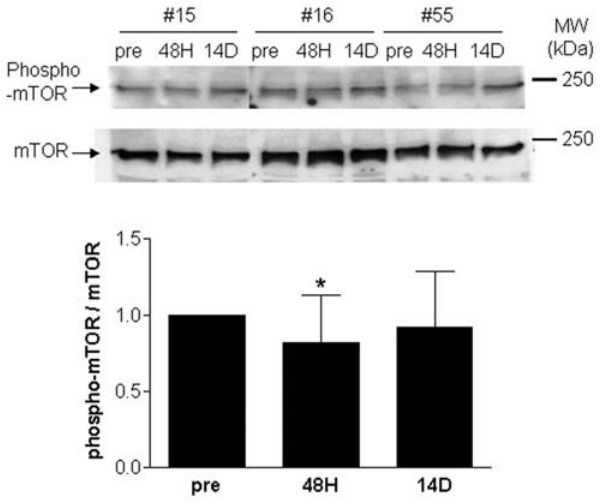
Figure 5. Changes in mTOR phosphorylation during immobi- lization-induced muscle atrophy. The protein level of phospho- mTOR was measured in muscle samples undergoing immobilization- induced muscle atrophy using Western blotting. Blots were then stripped and re-probed for total mTOR. Protein levels were normalized to tubulin. No significant differences in total mTOR protein levels were detected at any time-points (not shown), however the ratio of phospho- mTOR to mTOR decreased significantly (P # 0.05) at the 48 H time-point (asterisk) indicating decreased mTOR protein phosphorylation during the early phase of immobilization-induced muscle atrophy.